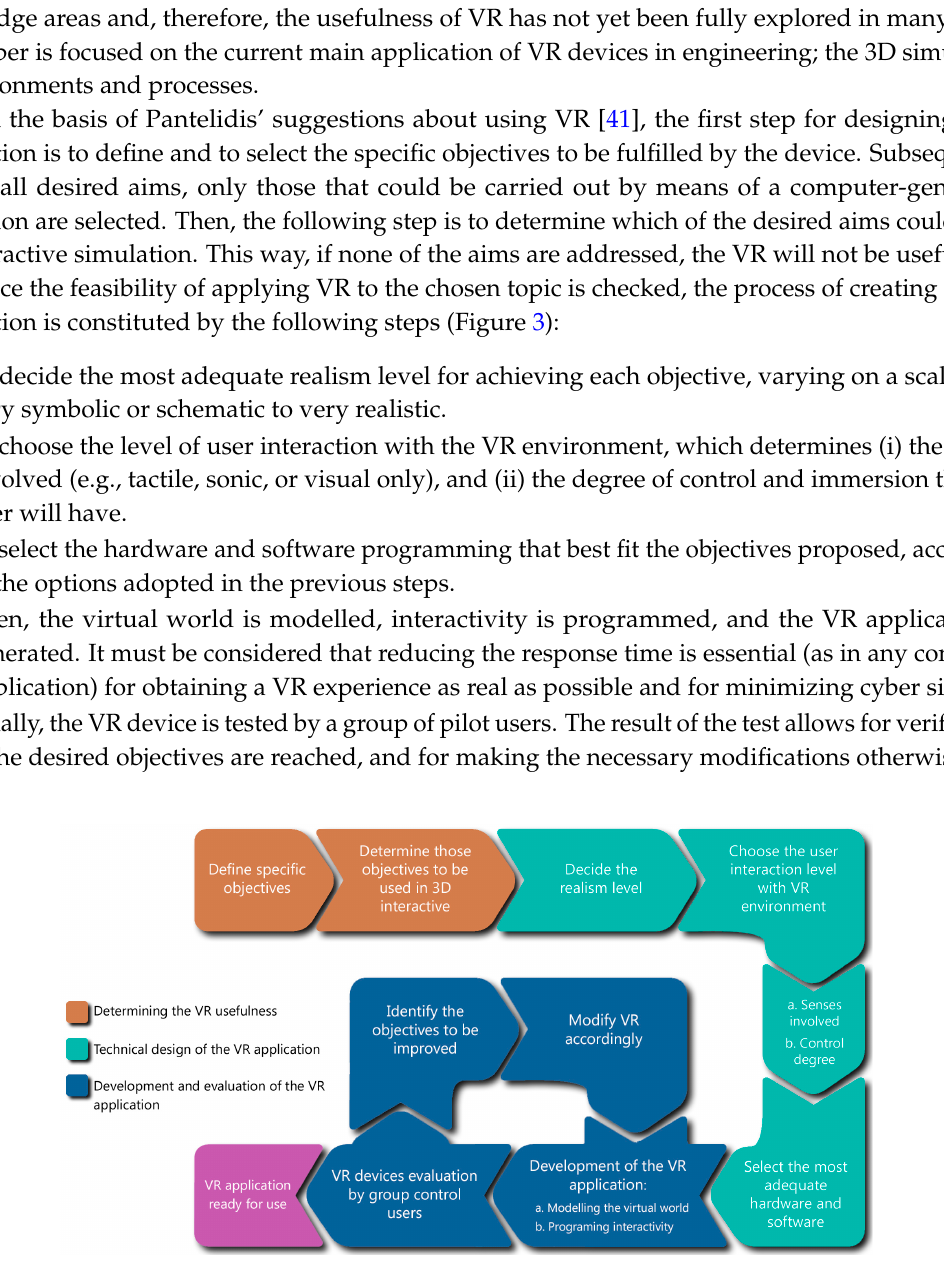
Figure 3. General flowchart for designing a VR application